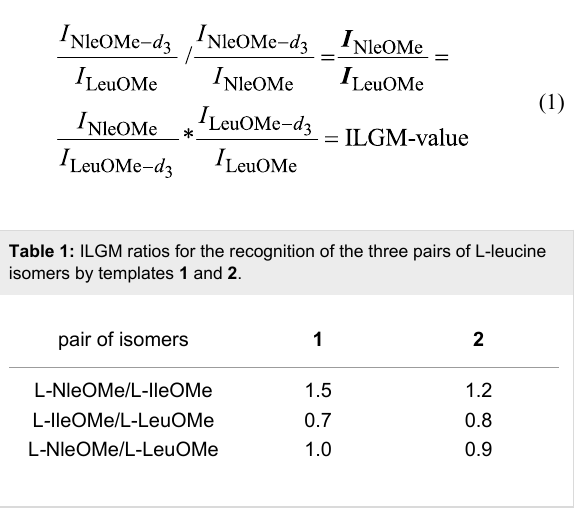
Table 1 lists the results of the ILGM measurements with regard to the affinity of templates 1 and 2 towards L-norleucine,